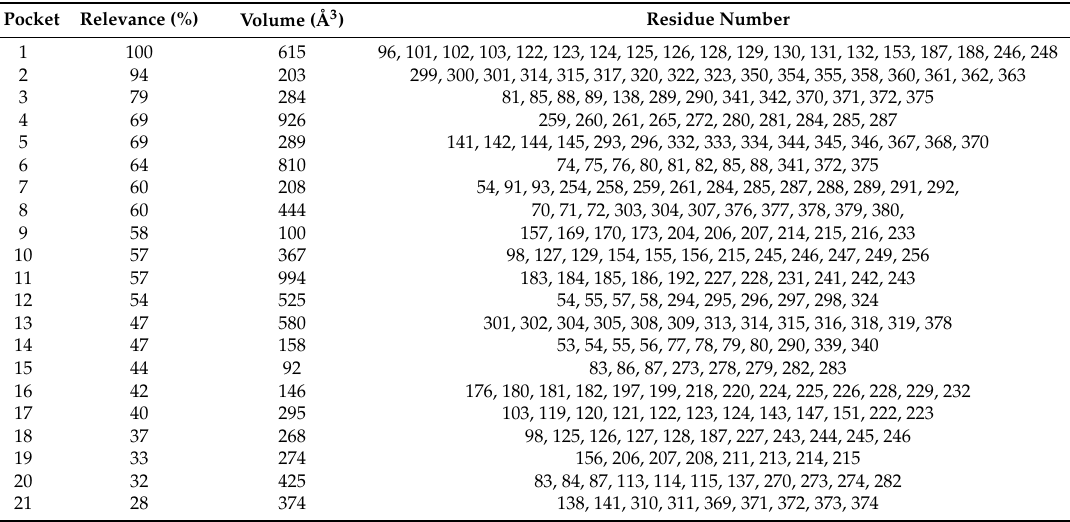
Figure 7. Regions in the hDKC1 three-dimensional (3D) structure model. hDKC1 is colored in beige. Residue K314 is indicated in blue ( A ) The PUA domain is colored in dark gray ( B ) Pocket 2 and Pocket 13 are highlighted in red and green, respectively. Table 2. Analysis of hydrophobic pockets present in the hDKC1 model by FPocket software.